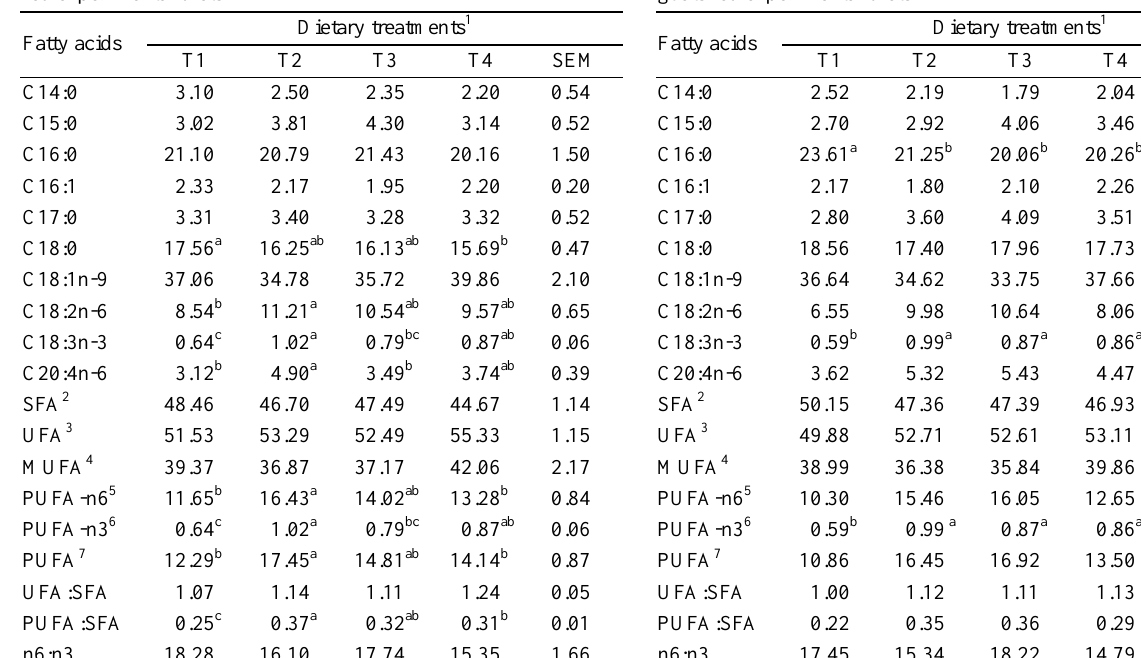
Table 3. Fatty acid composition (% of total identified fatty acids) of the intramuscular fat from the supraspinatus muscle in goats fed experimental diets